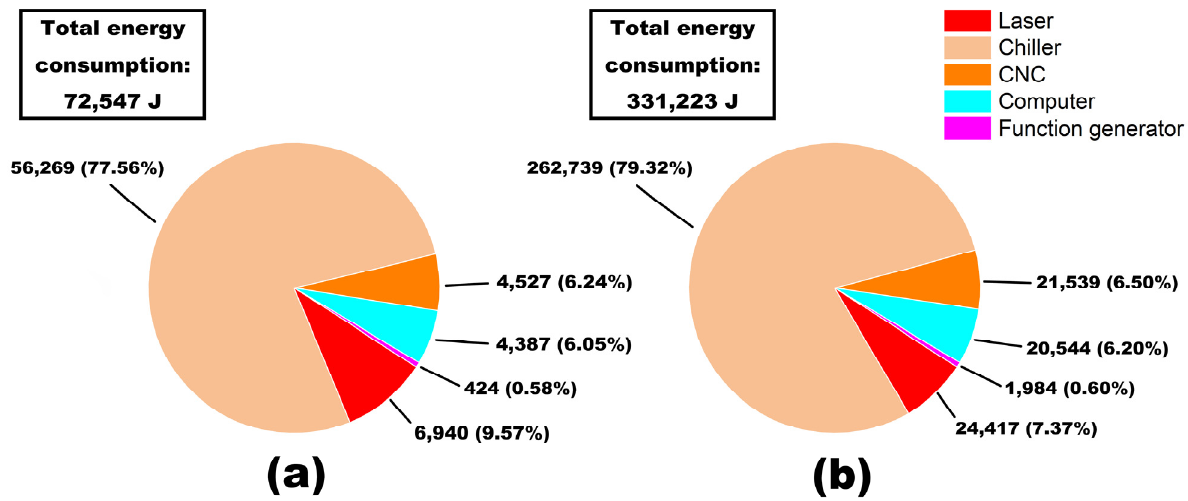
Figure 14. Energy consumption profile for ( a ) stepped laser parameter multiple-ring drilling method; ( b ) constant laser parameter multiple-ring drilling method. ( b ) constant laser parameter multiple-ring drilling